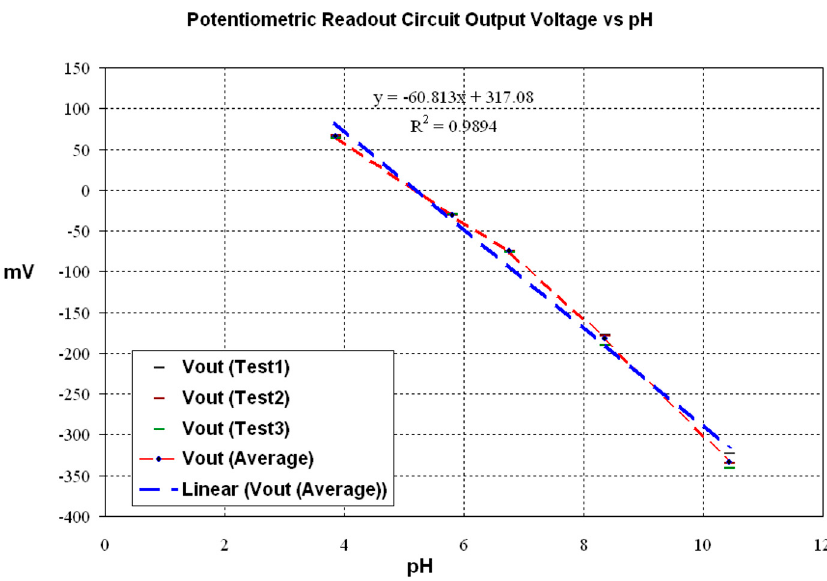
Figure 18. Conductivity measurement results compared with a commercial device.